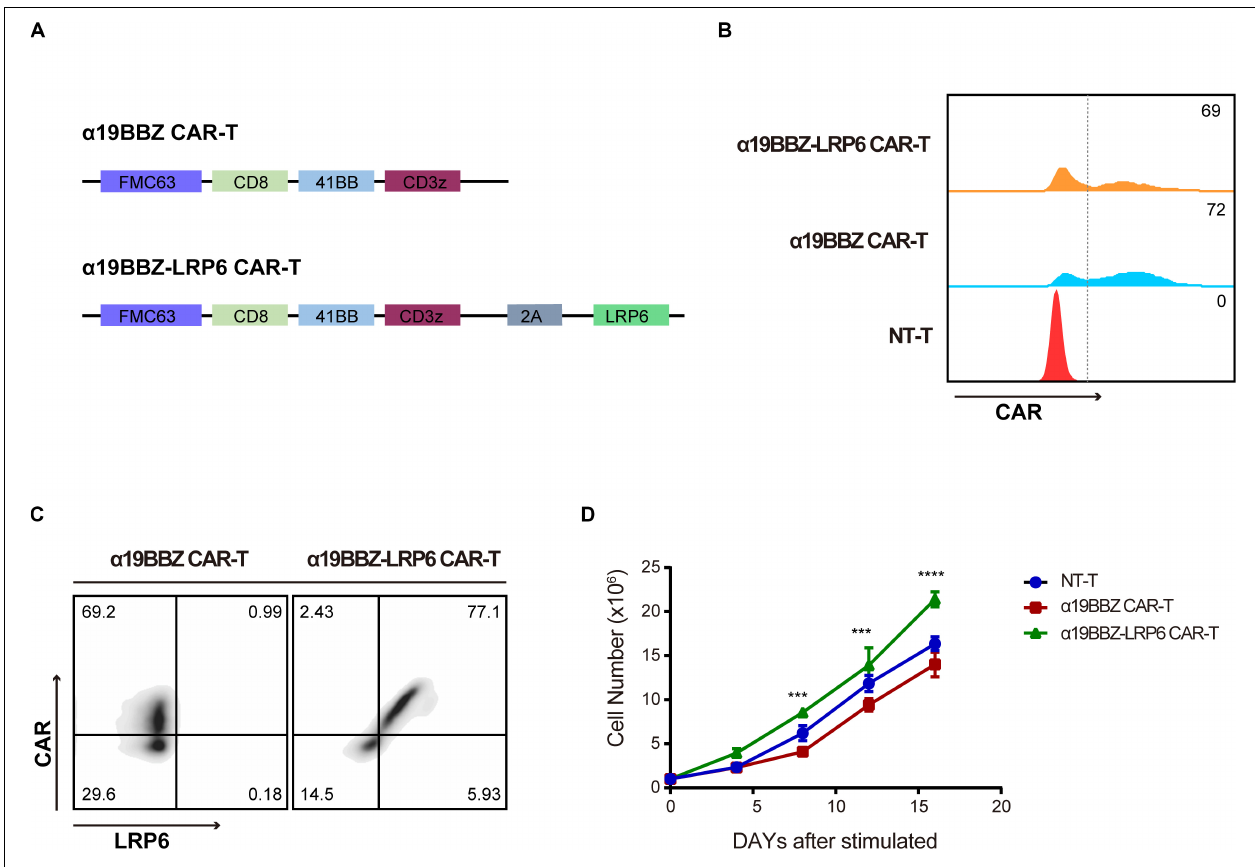
FIGURE 1 | The Characteristics of CARs. (A) The schematic of the CAR structure showing FMC63 scfv, CD8, 41BB, and CD3z with sequential connectivity. LRP6 is linked by a 2A sequence. (B) The expression of CAR on T cells. (C) The expression of LRP6 on the surface of CAR-T cells. (D) The proliferation curve of CAR-T cells and NT-T cells. The data was analyzed using the GraphPad Prism 6.0 software and 2-way ANOVA. Error bars indicate mean ± SD ( n = 3); *** P < 0.001; **** P <